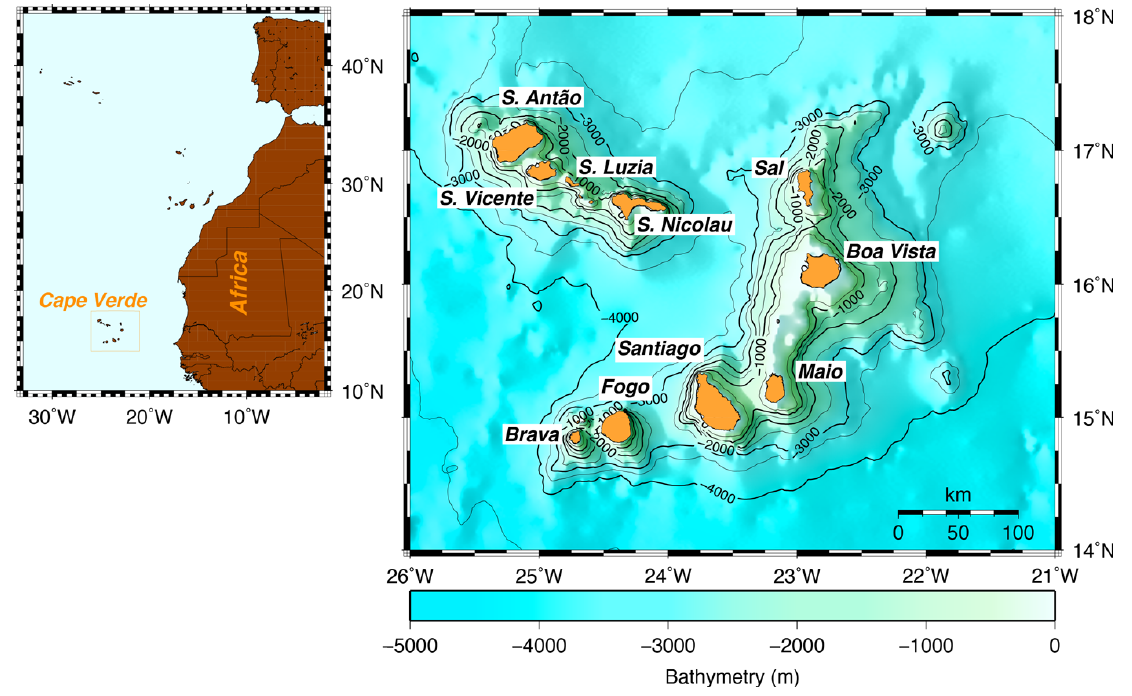
Fig. 1. (Left) Location of the archipelago, North Atlantic. (Right) Geographic distribution of the islands and bathymetry of the archipelago (contour interval